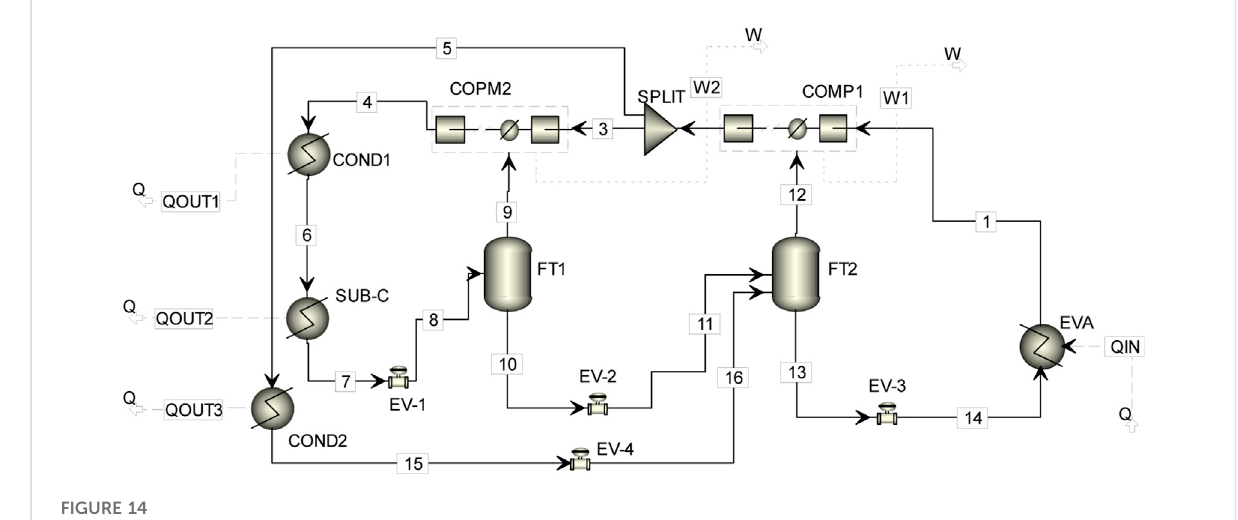
FIGURE 14 Simulation veri fi cation model.